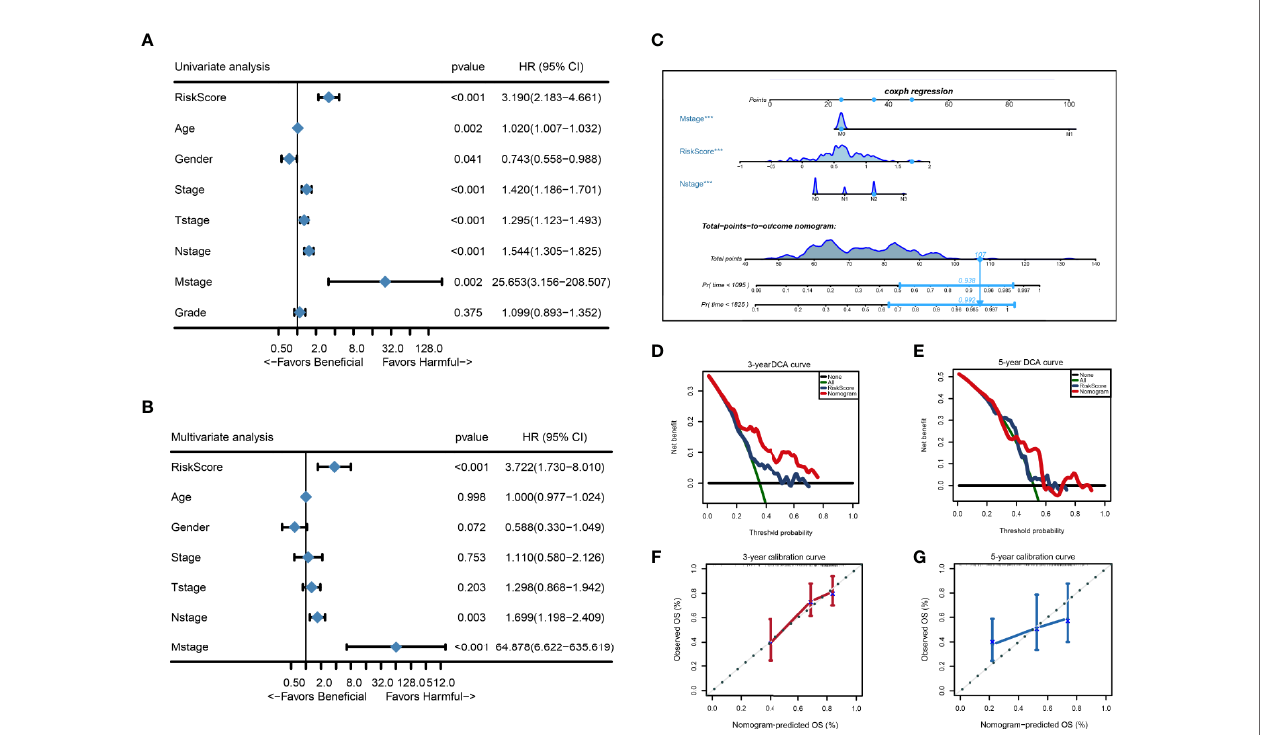
FIGURE 7 | Forest plot summary of univariate and multivariate analysis of 8-gene signature and nomogram to predict 3- and 5-year OS in TCGA-HNSC training set. (A, B) Univariable and multivariable analysis of OS for the TCGA-HNSC patients. The blue diamond squares on the transverse lines represent the HR and the gray transverse lines represent 95% CI. And the p value and 95% CI for each clinicopathological character were displayed in detail. (C) The nomogram for predicting proportion of patients with 3- or 5 - year OS. (D, E) Calibration curve for the prediction of 3- or 5- year overall survival. (F, G) DCA curve for the prediction of 3- or 5- year overall